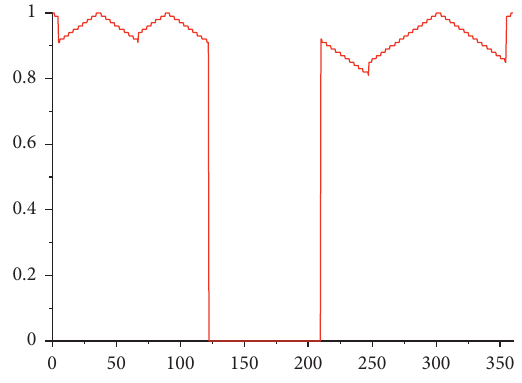
Figure 7: B membership function